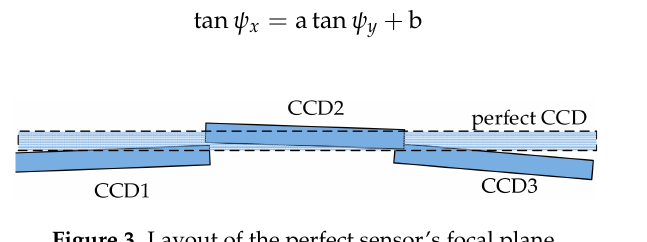
Figure 3. Layout of the perfect sensor’s focal